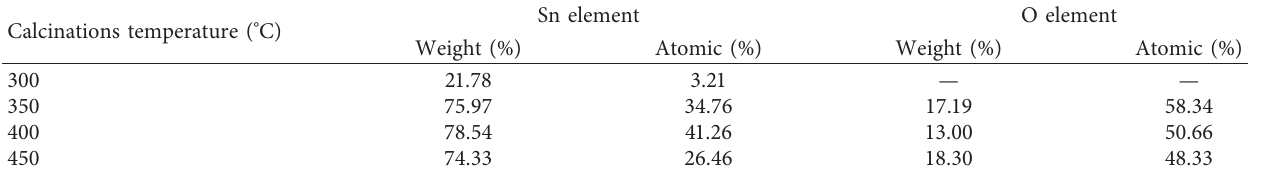
Table 2: The atomic and weight percentages of the mixture of Sn and oxide obtained from the EDX technique. Calcinations temperature ( °